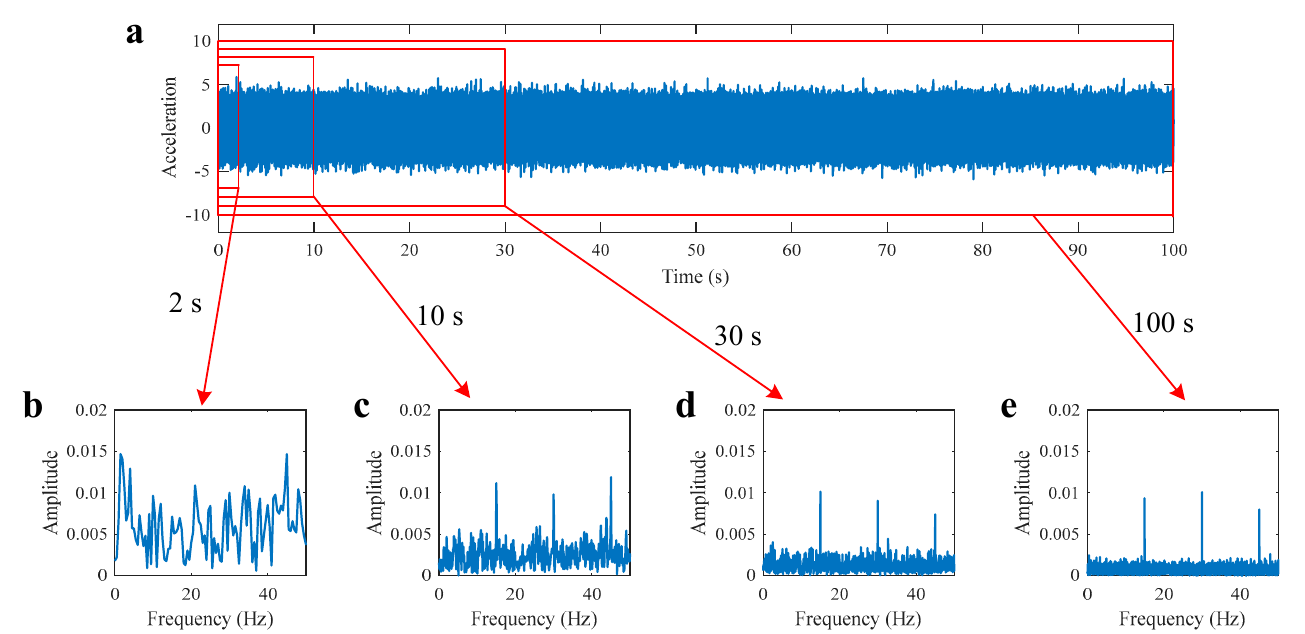
Figure 2. Fault bearing simulation signal and its envelope spectra: ( a ) Time domain signal with noise; ( b ) envelope spectrum of 2 s signal; ( c ) envelope spectrum of 10 s signal; ( d ) envelope spectrum of 30 s signal; ( e ) envelope spectrum of 100 s signal.